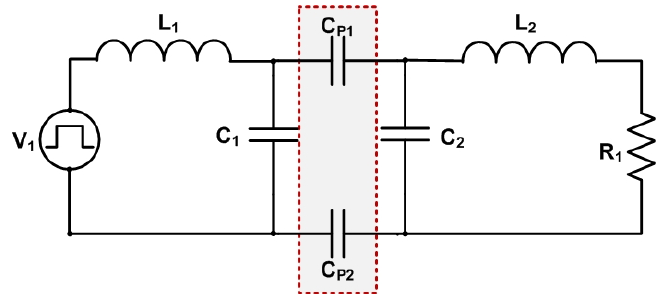
Figure 3. Z-Tank modified.